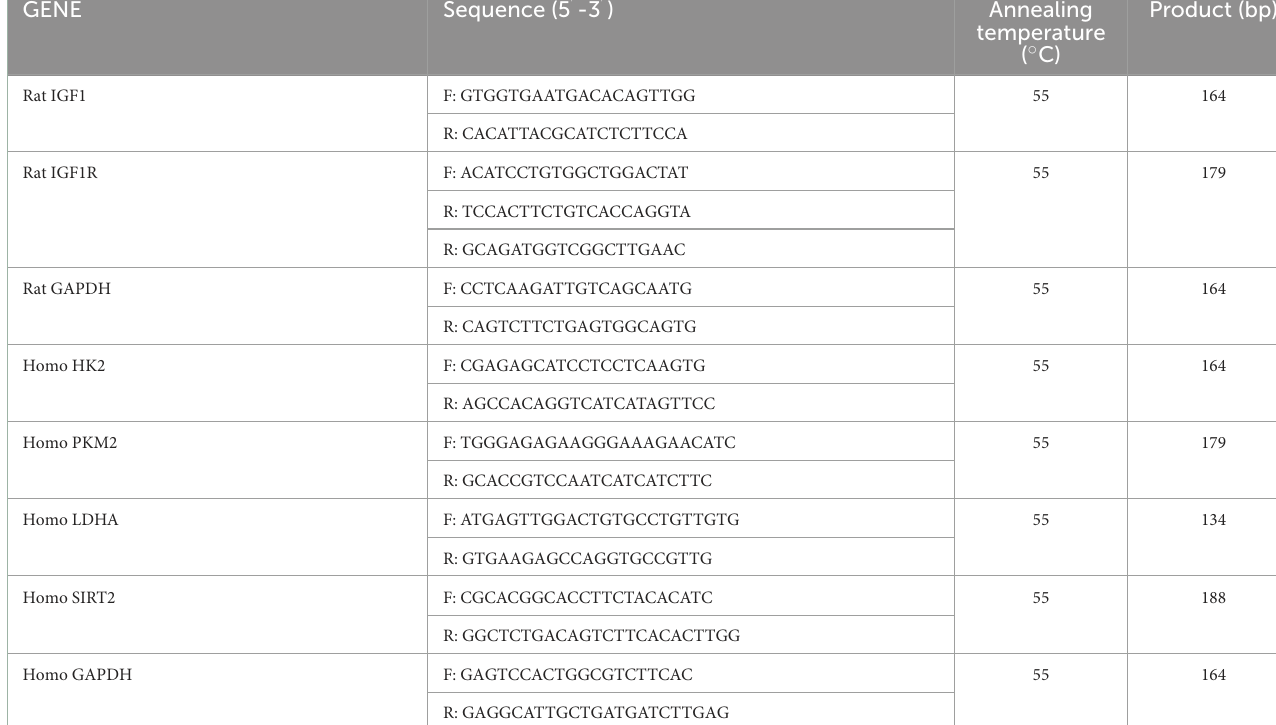
TABLE 1 Primer sequences used for the qRT-PCR analysis. GENE Sequence (5 ′ -3 ′